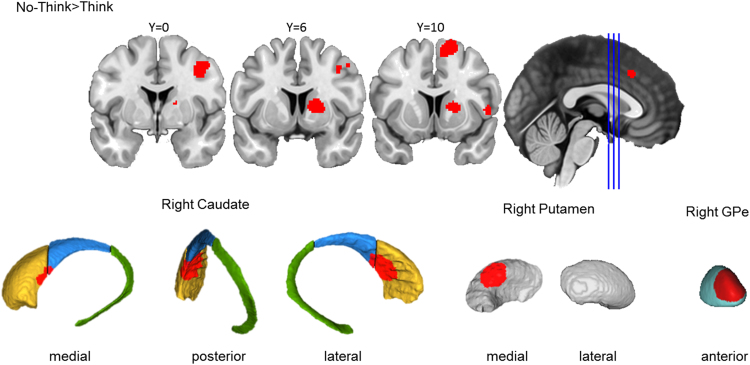
Memory inhibition engaged the right basal ganglia. Top row: Clusters are presented on coronal slices of a high-resolution MNI atlas. Reference lines for the coronal slices are presented in the sagittal plane. Bottom row: Clusters are displayed on high-resolution parcellations of the caudate, putamen, and external globus pallidus (GPe). All clusters are thresholded using cluster-level inference (p<.05, uncorrected p<.001, threshold permutations=1000).